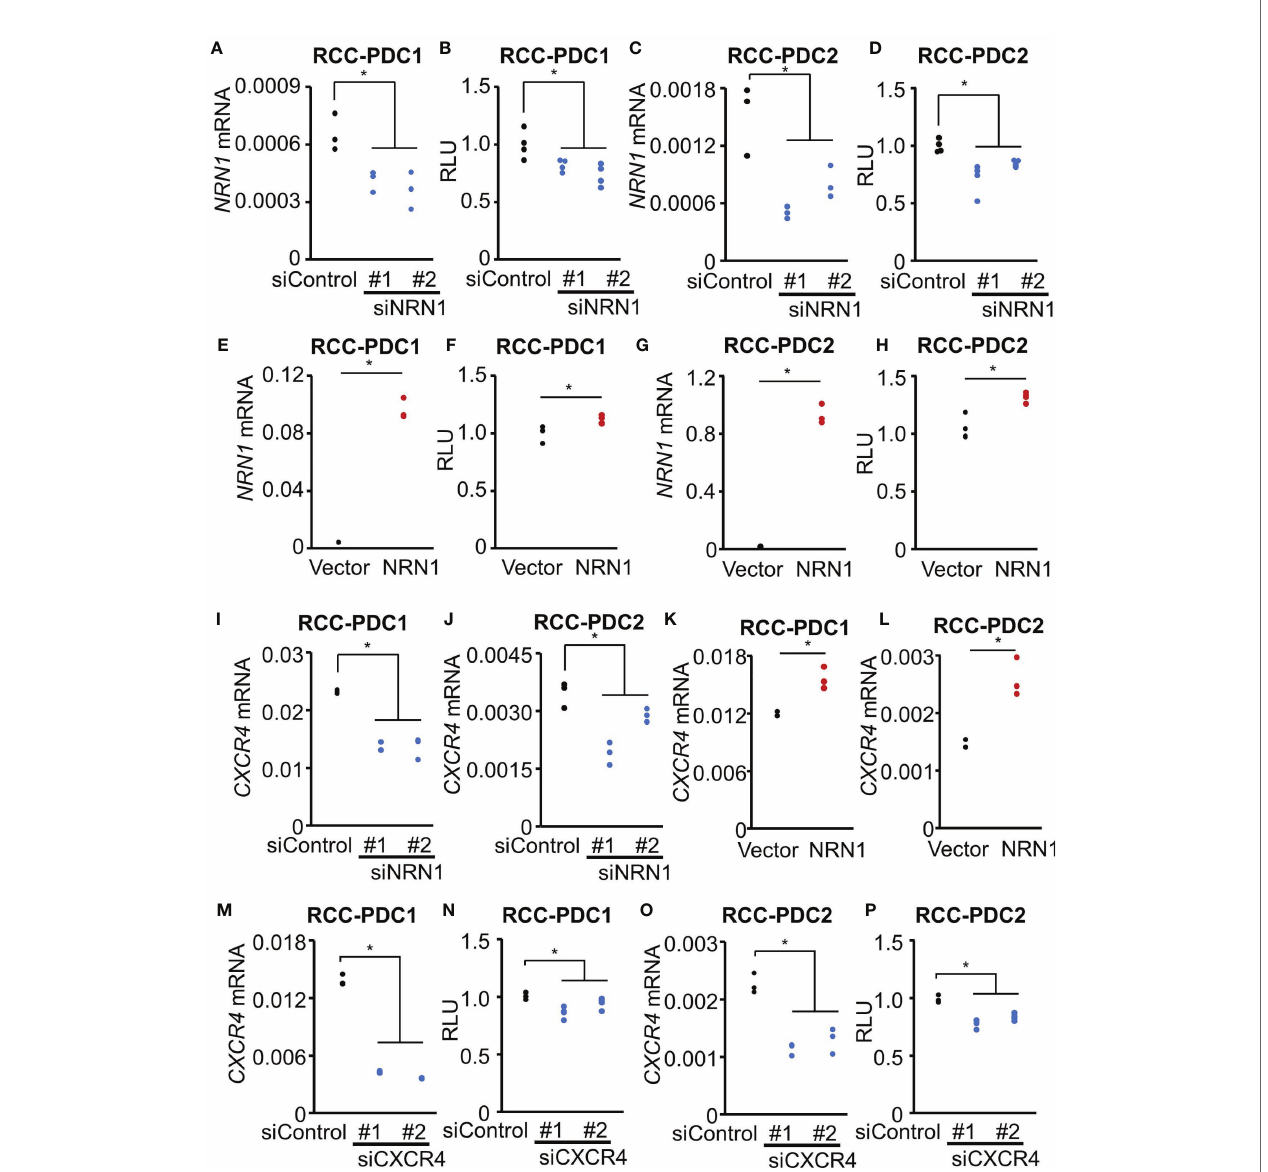
FIGURE 3 | NRN1 and CXCR4 promote RCC-PDC viability. (A – H) NRN1 silencing decreases whereas overexpression increases PDC viability. RCC-PDC1/2 spheroid cultures were transfected with NRN1 (siNRN1 #1 and #2) or control (siControl) siRNAs (A – D) , and NRN1 or control expression vector (E – H) . NRN1 mRNA levels were analyzed by qRT-PCR (A, C, E, G) ( n = 3) and spheroid growth was estimated by cell viability assay based on ATP quanti fi cation in cell lysates (B, D, F, H) ( n = 4). Data are shown as means ± SD. * P < 0.05 by two-sided Student ’ s t -test. (I – L) NRN1 silencing decreases whereas overexpression increases CXCR4 expression. RCC-PDC1/2 were transfected with siRNAs: siNRN1 #1, #2, or siControl (I, J) , or expression vectors (NRN1 or control vector) (K, L) . (M – P) CXCR4 silencing represses PDC viability. RCC-PDC1 and 2 were transfected with siRNAs targeting CXCR4 (siCXCR4 #1 and #2) or siControl. CXCR4 mRNA levels were analyzed by qRT-PCR (M, O) and spheroid growth was estimated by cell viability assay (N, P) . Data are shown as means ± SD, n = 3. * P < 0.05 by two-sided Student ’ s t